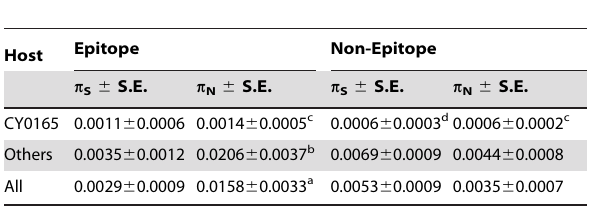
Table 3. Synonymous ( p S ) and nonsynonymous ( p N ) nucleotide diversity in epitope and non-epitope regions from all animals.